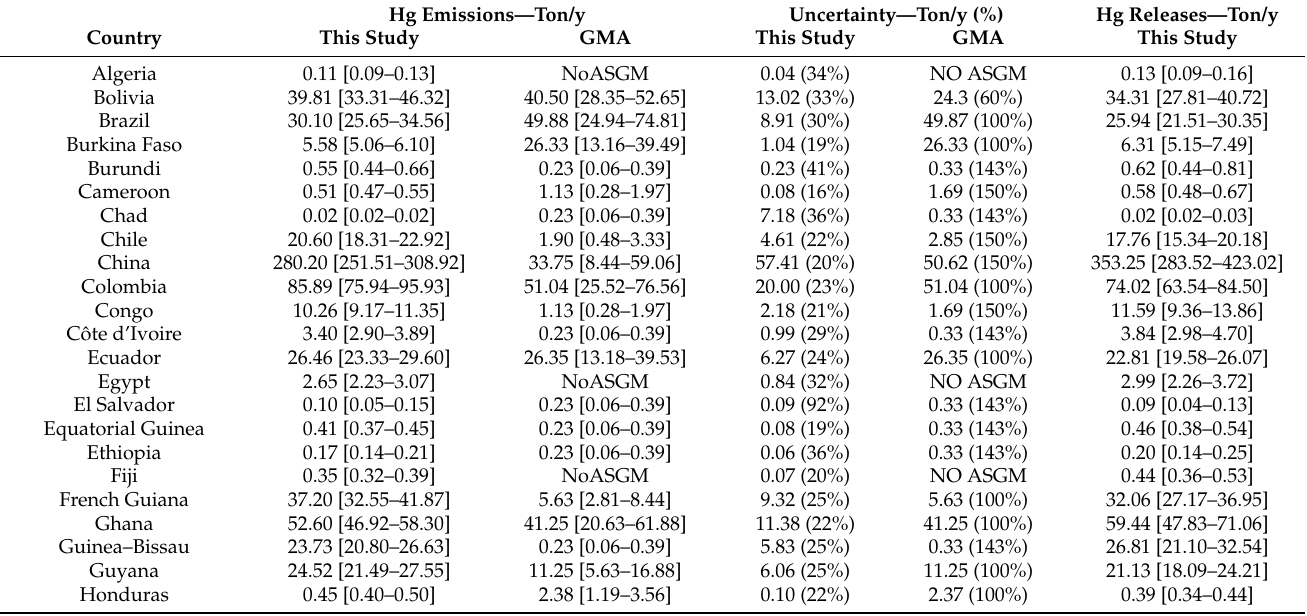
Table 2. Summary of the Hg emissions from ASGM estimated in this study, compared to GMA estimates. NoASGM indicates that for that country, no Hg emissions from ASGM is assessed by